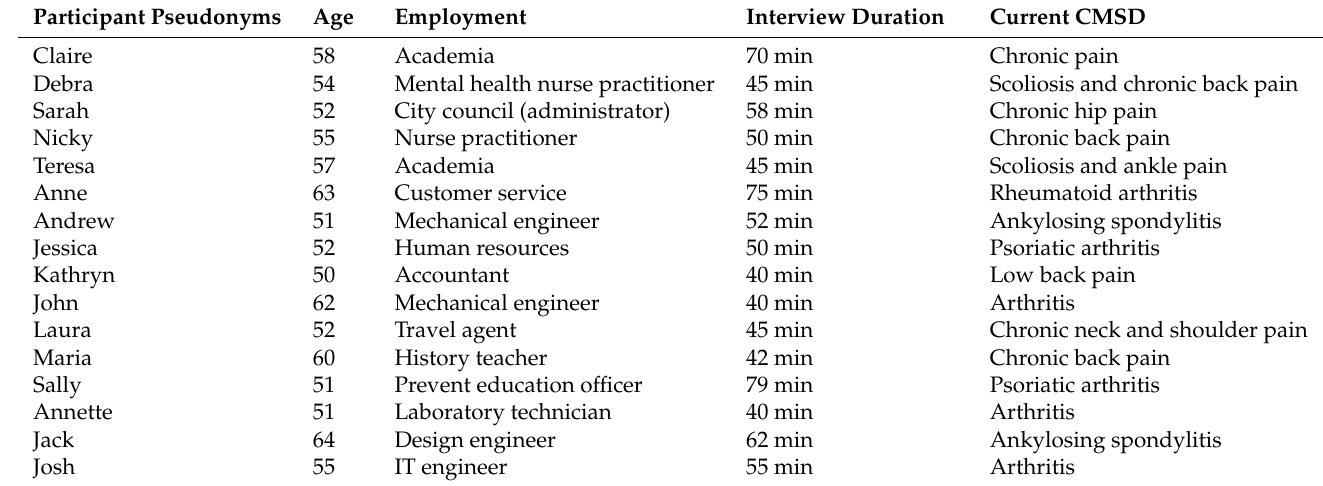
Table 4. Socio-demographic characteristics of interview participants.